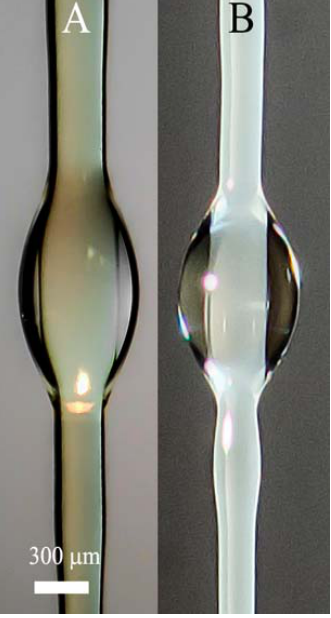
Figure 7. Enlarged images of solvent droplets on fiber surfaces for CPABI in DMAc solution ( A ) and PAN in DMSO solution ( B ).